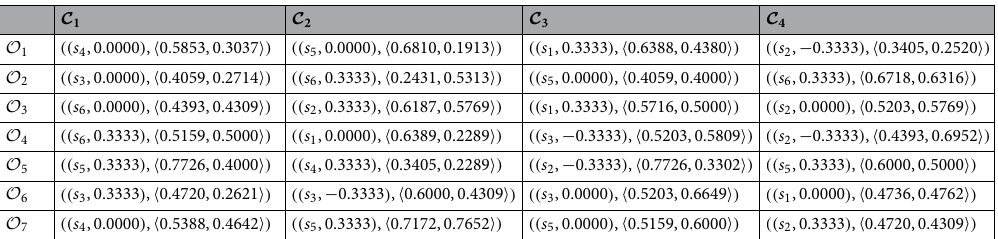
Table 4. Aggregated q-ROPFL decision